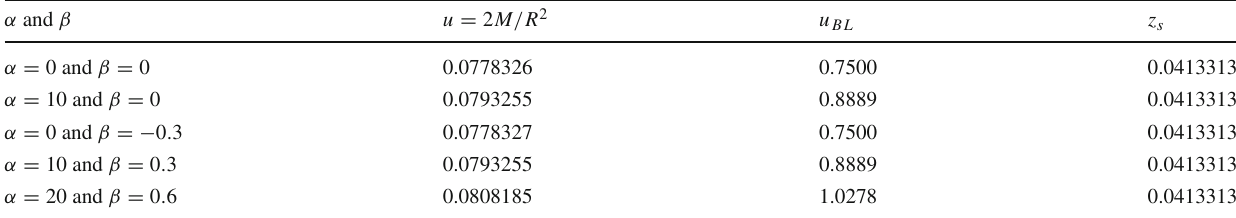
Table 2 The compactness and surface redshift values along with the Buchdahl limit ( u BL ) in EGB gravity for R = 9 km and C = 0 . 001 km − 2 with different GB constant α and coupling parameter β corresponding to the MGD solution Sect. 3.2: α and β u = 2 M / R 2 u